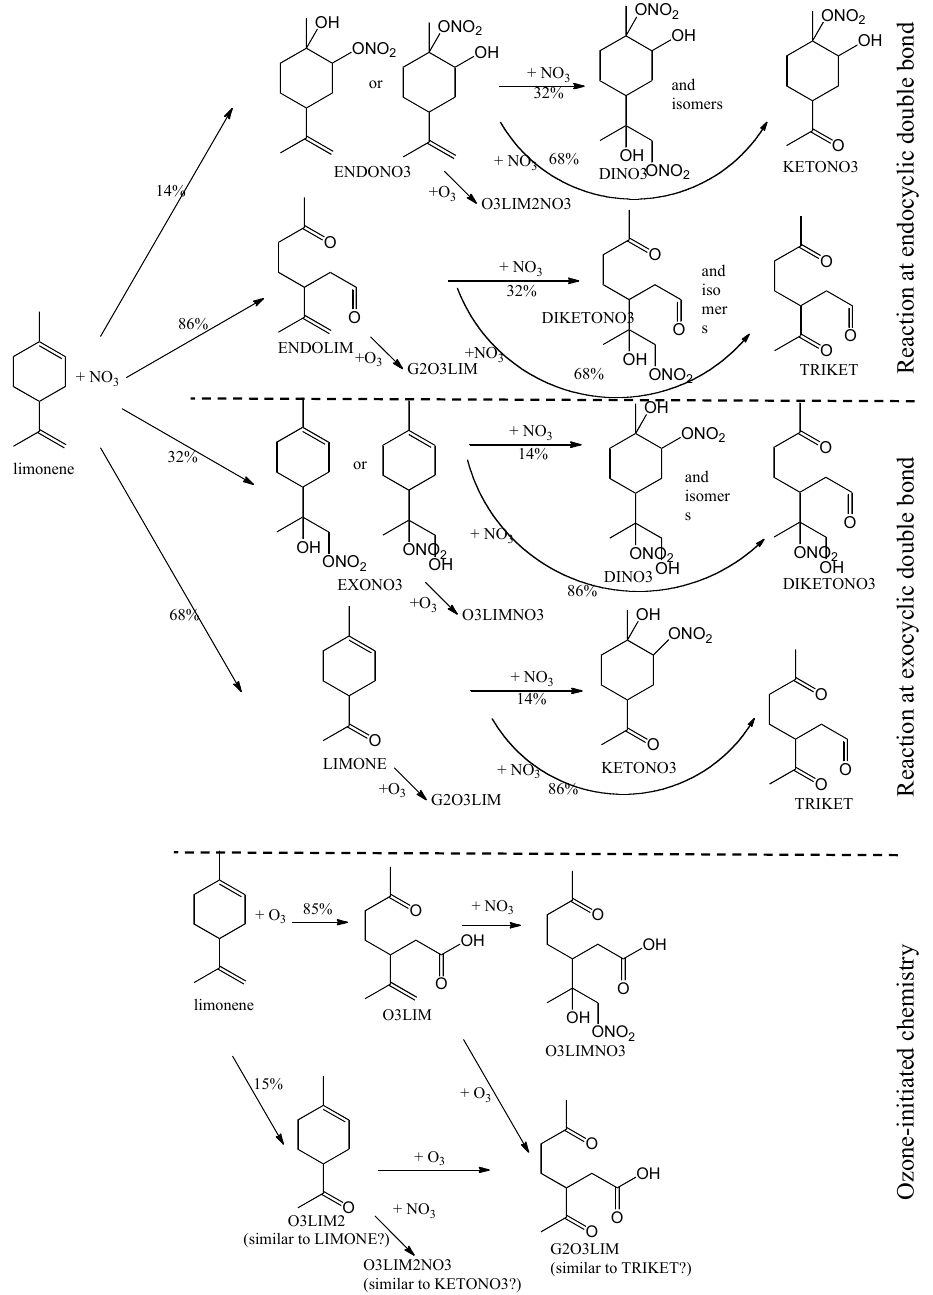
Fig. 3. Reaction scheme of NO 3 and O 3 oxidation of limonene. Structures (especially O 3 products) are proposed approximations; names correspond to individual molecular species tracked in model mechanism.